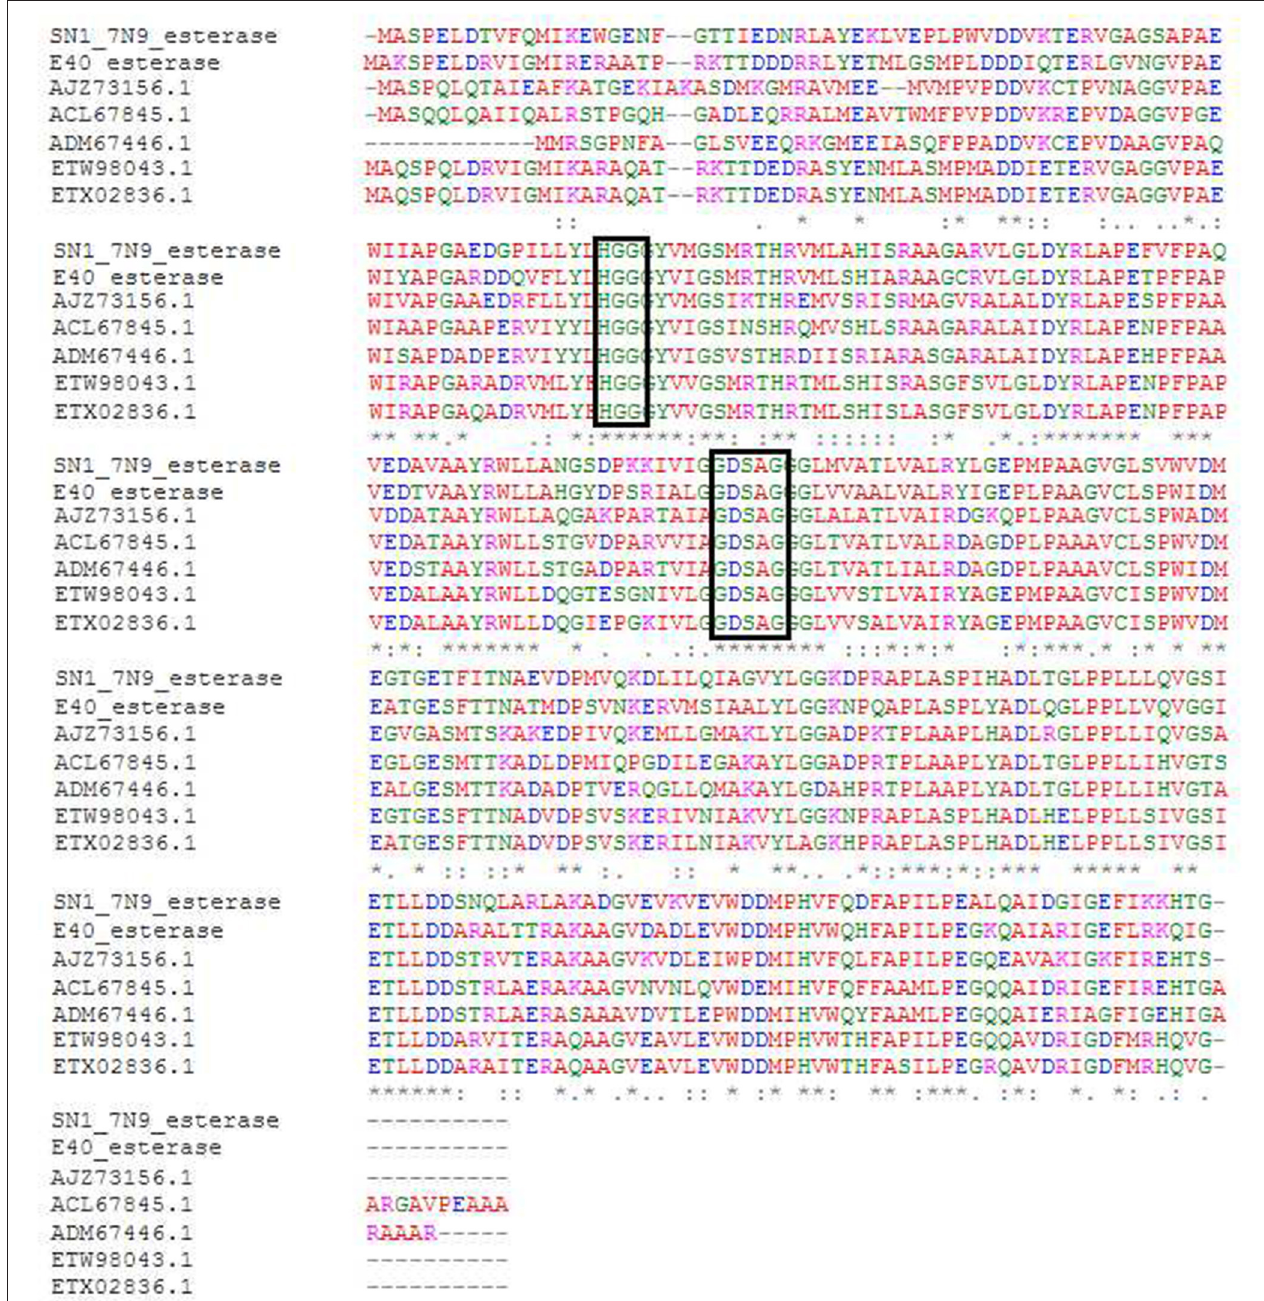
FIGURE 3 | Multiple sequence alignment of most closely related esterase sequences. The conserved GDSAG (GXSXG) and HGG motifs are shown in the black boxes. Red indicates small hydrophobic and aromatic amino acids, blue indicates acidic amino acids, magenta indicates basic amino acids, and green indicates hydroxyl, sulfhydryl amino acids, and glycine. (*) Indicates a fully conserved residue, (:) indicates a group of strongly similar residues, and (.) indicates conservation of a group of weakly similar residues. The alignment was produced by Clustal Omega (Sievers et al., 2011; McWilliam et al., 2013; Li W. et al., 2015) and MEGA6 (Tamura et al.,